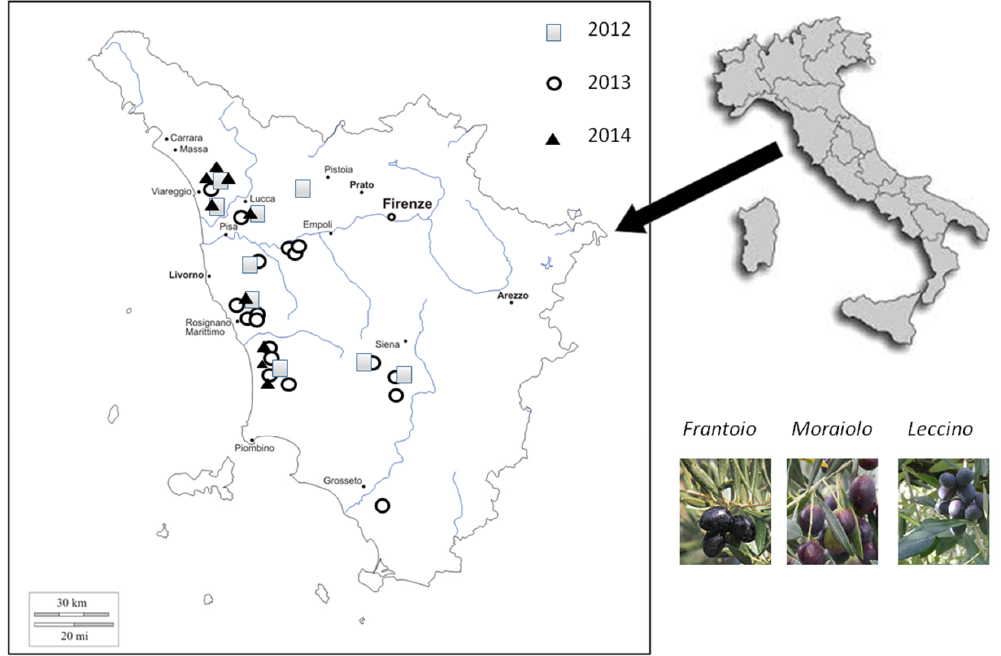
Figure 1. Extra ‐ virgin olive oil samples of different harvesting years (2012, 2013, and 2014) produced in Tuscany (Italy) from a blend of Leccino , Moraiolo , and Frantoio cultivars. The location of olives’ origin is indicated for all investigated